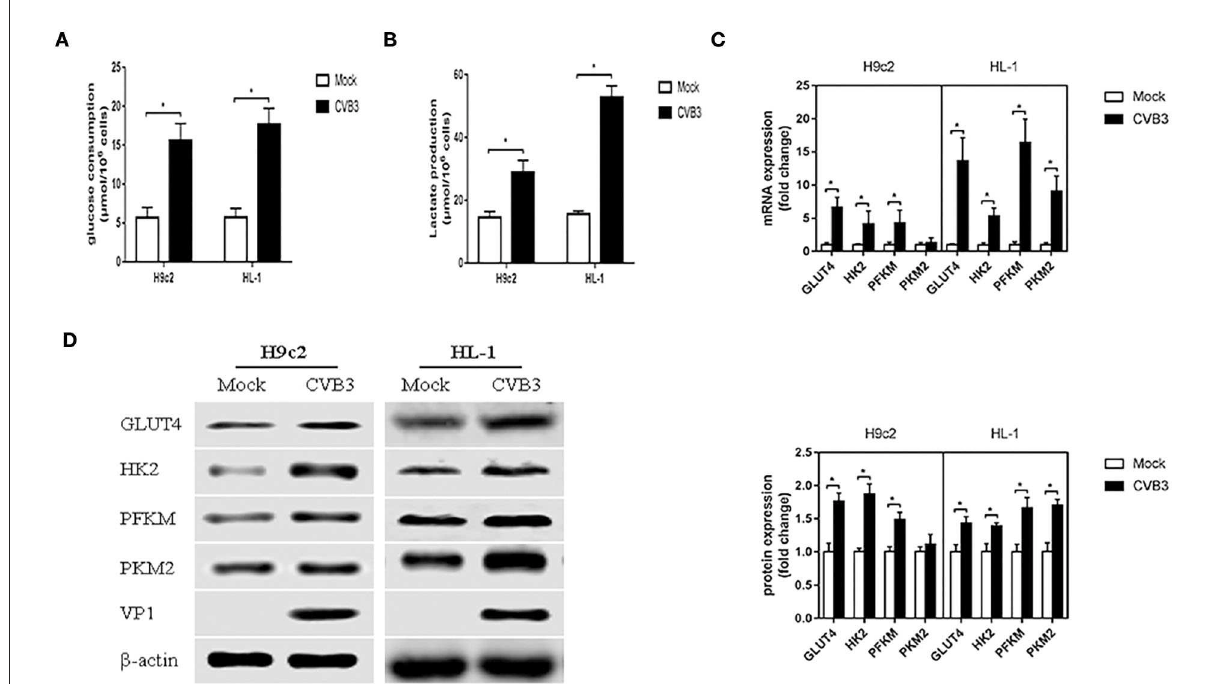
FIGURE1 Coxsackievirus B3 infection induces glycolysis. Myocardial cells, H9c2 and HL-1 cells, were mock-infected or infected with coxsackievirus B3 at a multiplicity of infection of 10, and were harvested at 24h post-infection. Glucose consumption (A) and lactate production (B) were measured and calculated. The expressions of GLUT4, HK2, PFKM, and PKM2 were analyzed by qPCR (C) and Western blot (D) . Data are indicated as mean ± SEM; data represent three independent experiments with three technical replicates per experiment; * P <